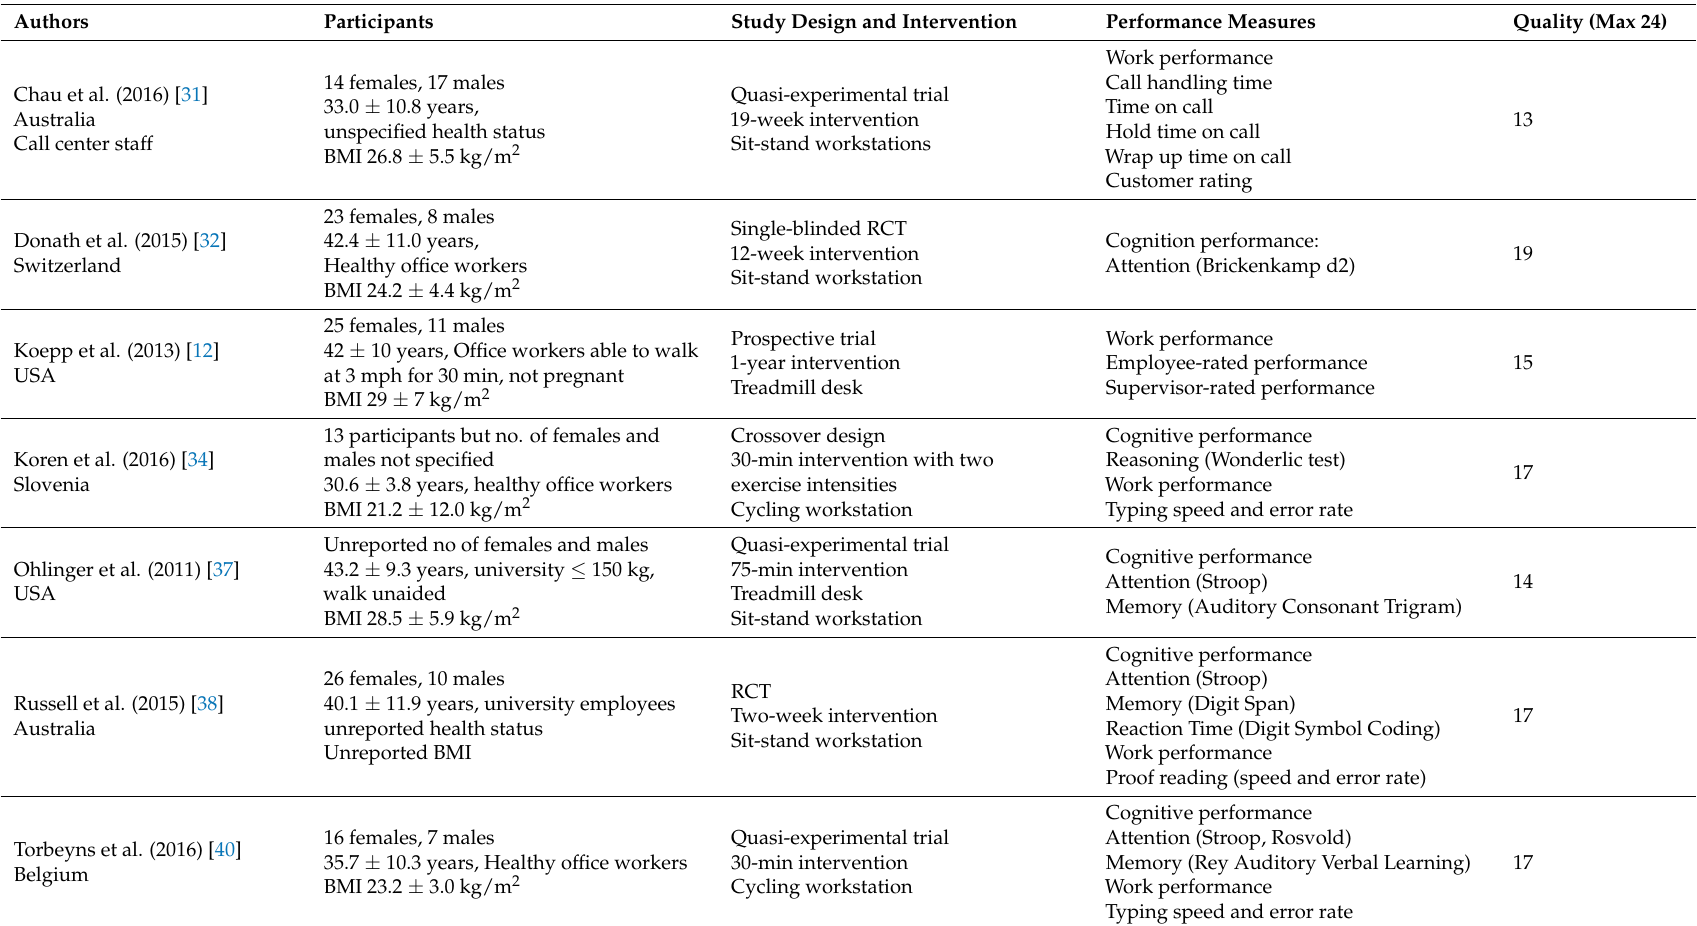
Table 2. Characteristics of the selected